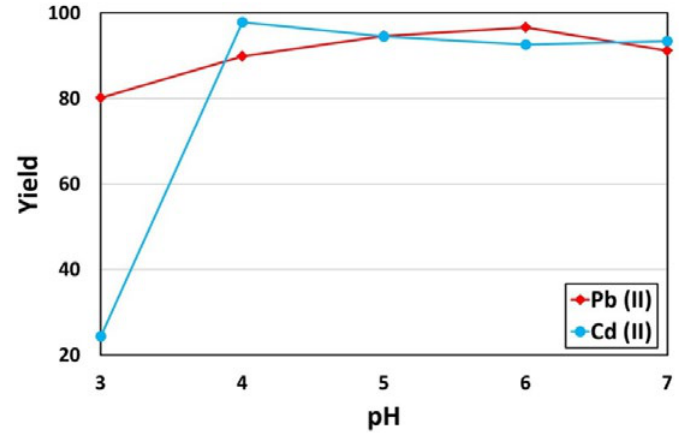
Fig. 5. Effect of pH on the removal of Pb 2+ and Cd 2+ ions